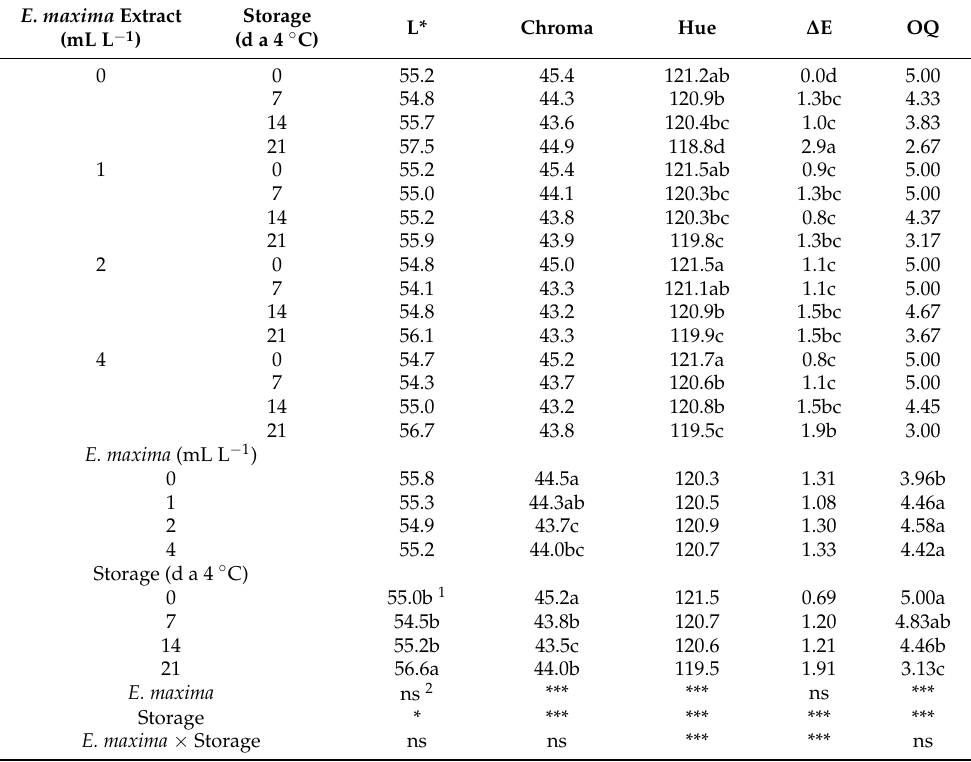
Table 4. Effect of different concentrations of Ecklonia maxima extract in the nutrient solution and cold storage on leaf appearance of fresh-cut leaf